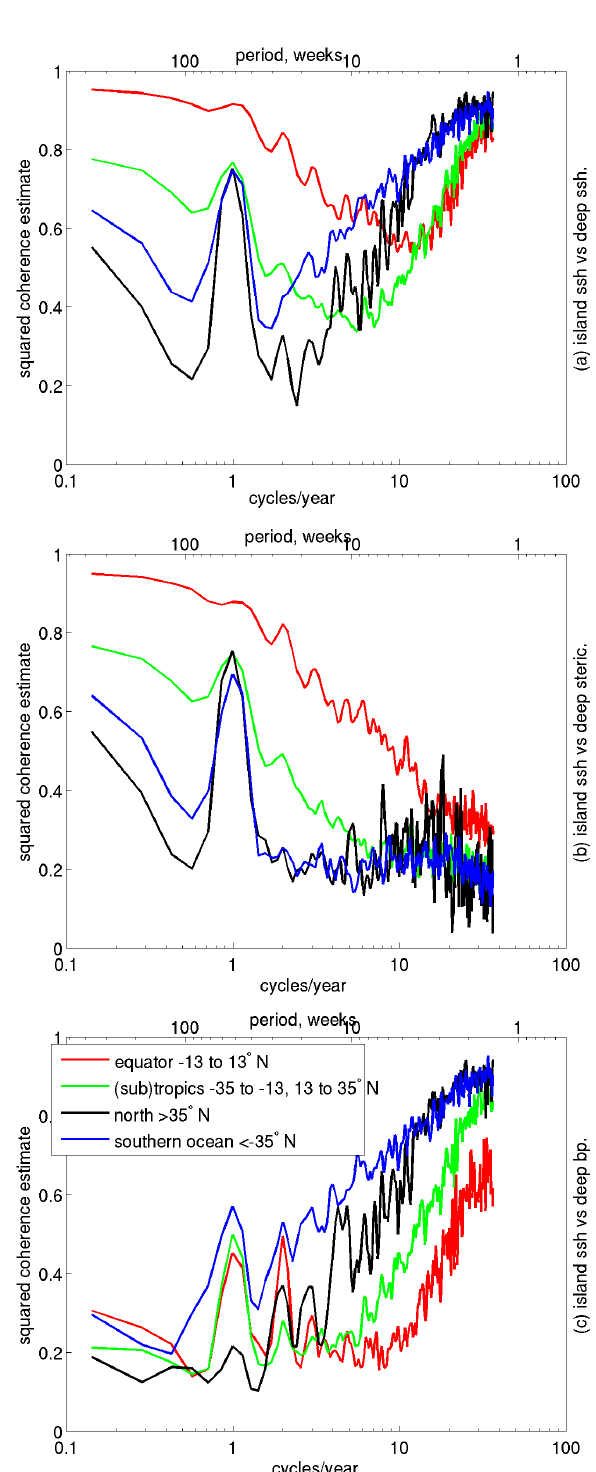
Fig. 5. Magnitude squared coherence estimate by frequency for sea-surface height at island and (a) sea-surface height ( h ), (b) steric height ( φ ), and (c) bottom pressure ( p ), in deep water nearby, aver- aged over latitude